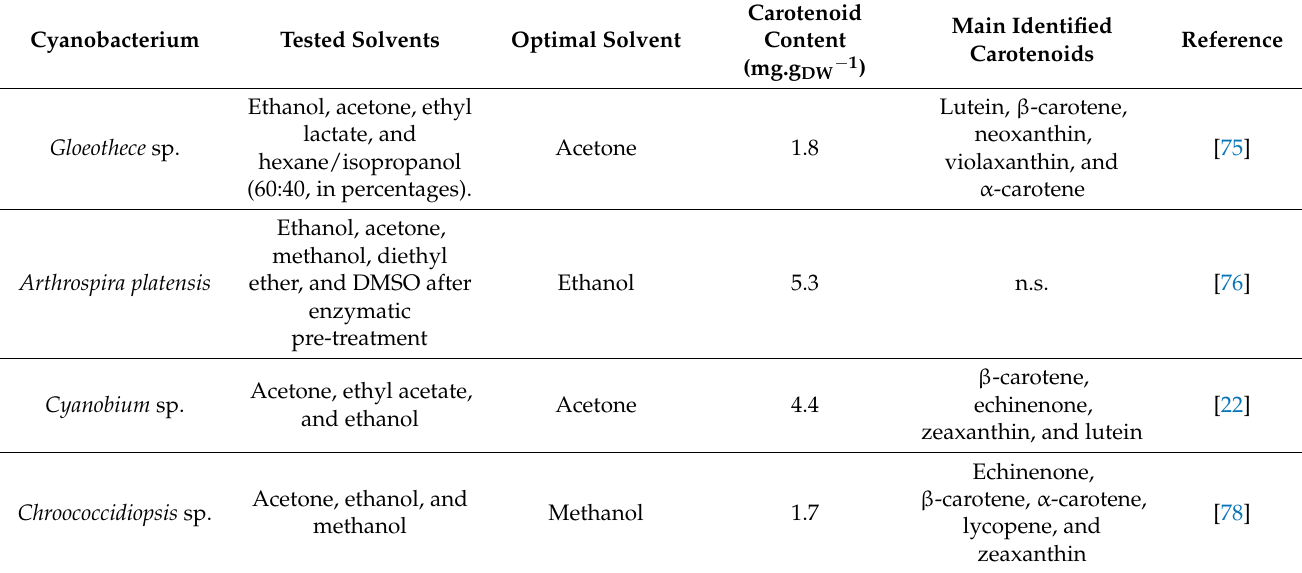
Chroococcidiopsis